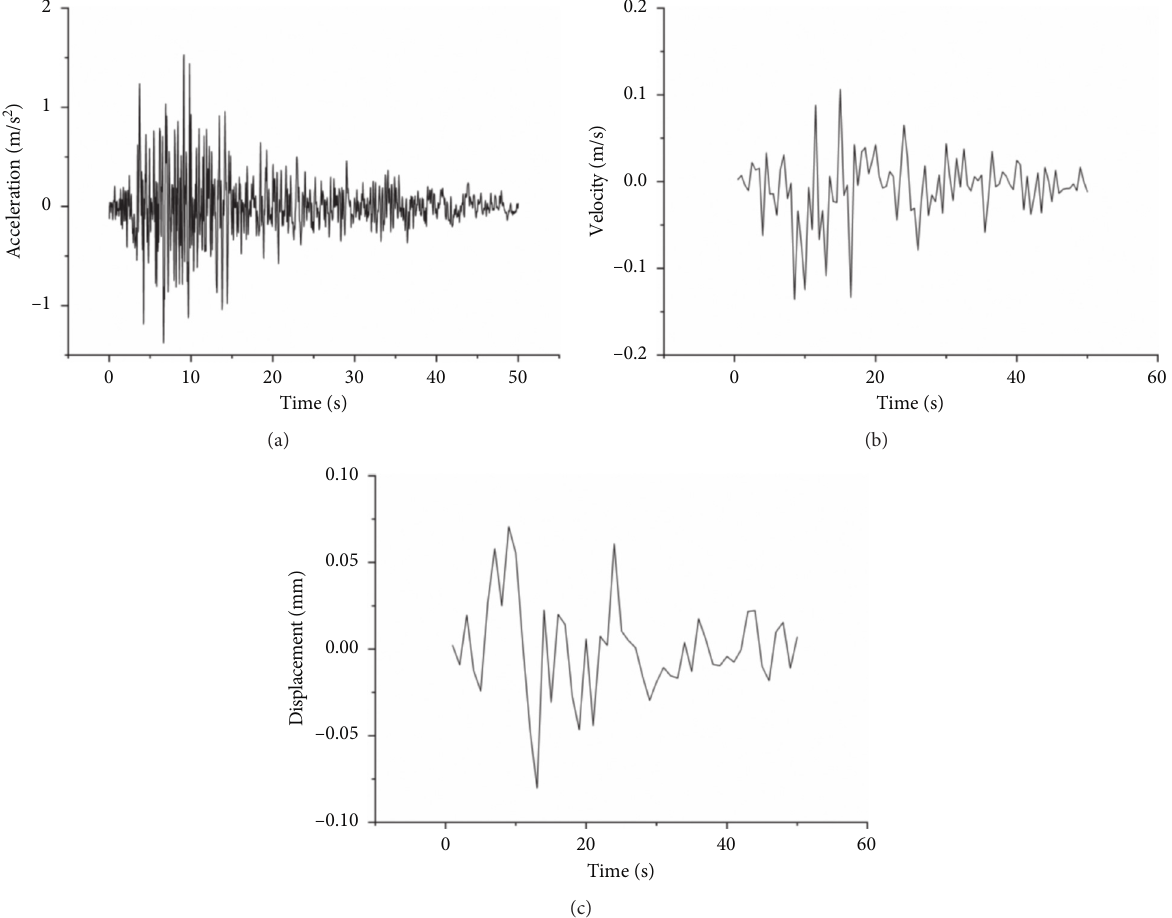
Figure 11: Time history of the Taft wave. (a) Lateral acceleration-time curve. (b) Lateral velocity-time curve. (c) Lateral displacement-time